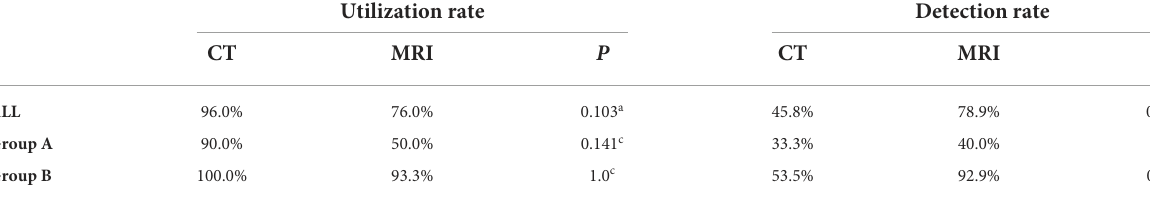
TABLE 3 The comparison of CT and MRI in the diagnosis of intraorbital wooden foreign